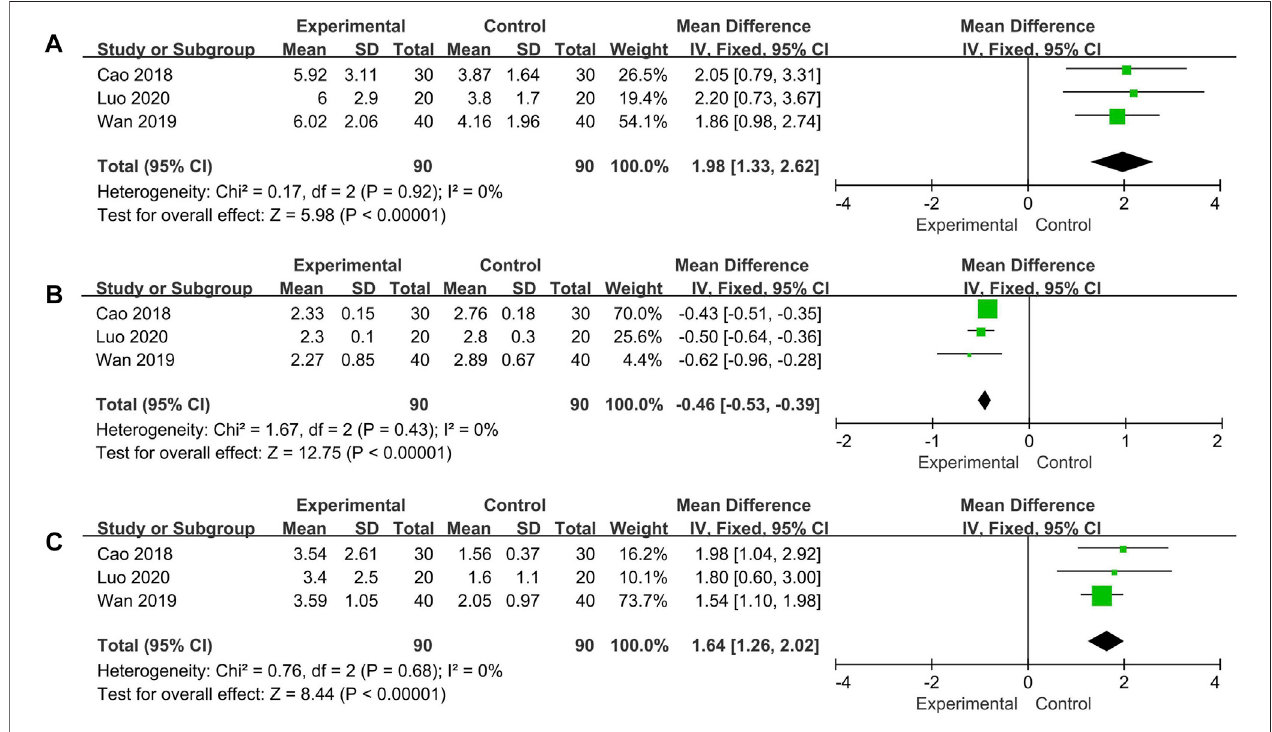
FIGURE 7 | Forest plot of IFN- γ (A) , IL-4 (B) and Th1/Th2 (C) .